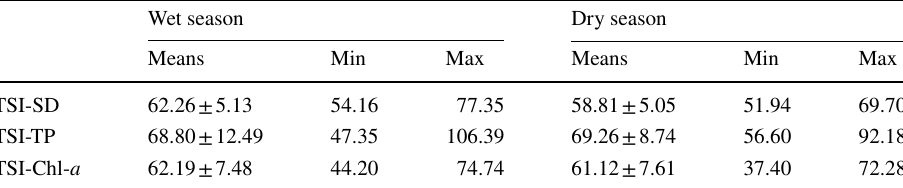
Table 6 Mean ± Std. Dev. and range of the TSI values between seasons ( n = 108)